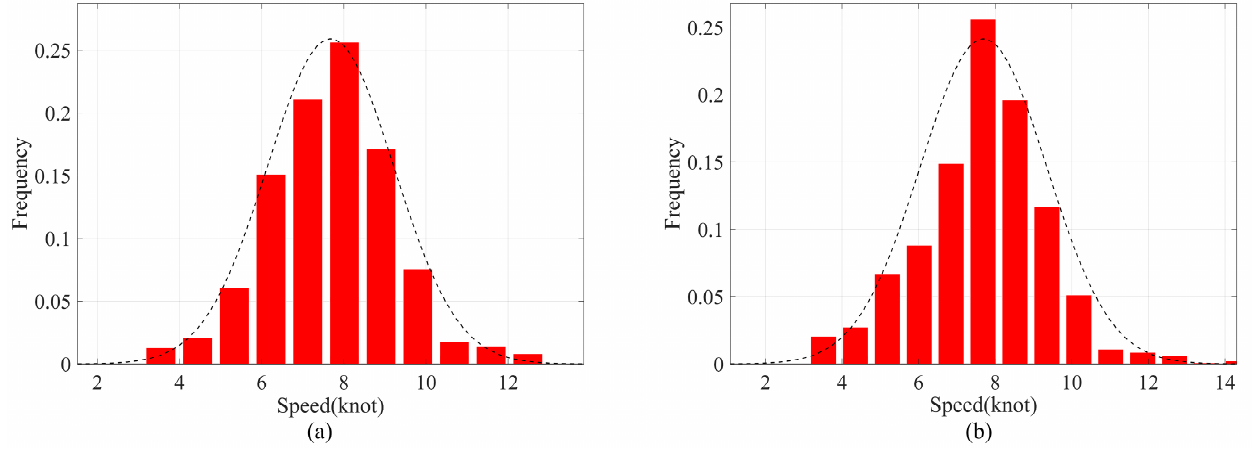
Figure 17. Frequency histogram of outgoing and incoming ship speed. ( a ) Frequency histogram of speed of outgoing ships; ( b ) frequency histogram of speed of incoming ships.